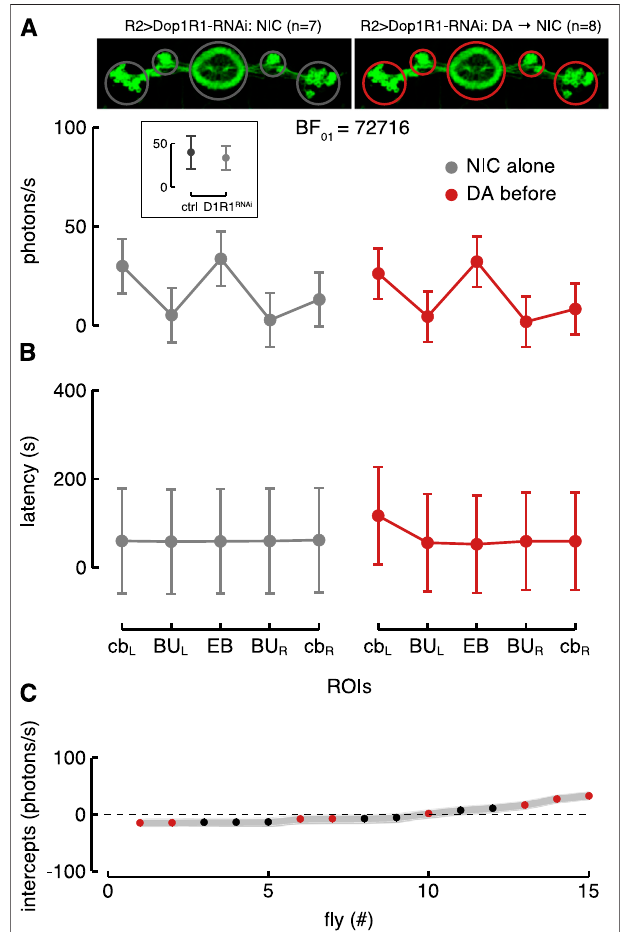
FIGURE 7 | Knockdown of Dop1R1 in R2 > G5A fl ies. (A) Estimated parameters of the Ca 2+ -response referred to the interaction between condition and ROIs with corresponding CI (computed as in Figure 5C ). The insetrepresentsthecomparison oftheestimated interactionparameters (i.e.,betweencondition andROIs) referred toEBintheR2normal (ctrl)and R2 > Dop1R1-RNAi (D1R1 RNAi ) fl ies in response to nicotine. On the left is represented the Ca 2+ -response to nicotine (NIC) alone in the fi ve ROIs of the R2 neurons with knockdown of Dop1R1 (R2 > Dop1R1-RNAi; grey, n = 7), while on the right is represented their Ca 2+ -response to nicotine after dopamine (DA) application (red, n = 8). (B) Estimated parameters of the response latency referred to the interaction between condition and ROIs (computedasin Figure5D ).Ontheleftisrepresentedthelatencyresponseto nicotine alone in the fi ve ROIs of the R2 neurons with knockdown of Dop1R1 (grey) while on the right is represented their latency response to nicotine after dopamine application (red). (C) Plot of random effect referred to Ca 2+ - response (as in Figure 5E ).